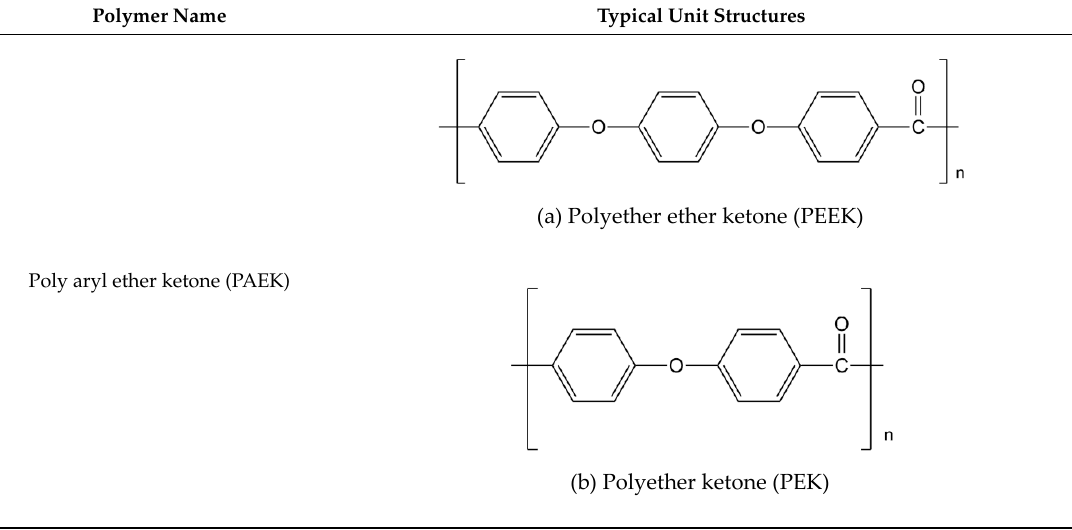
Table 1. Typical unit structures of several aromatic-based polymers used as proton exchange membrane (PEM) materials.